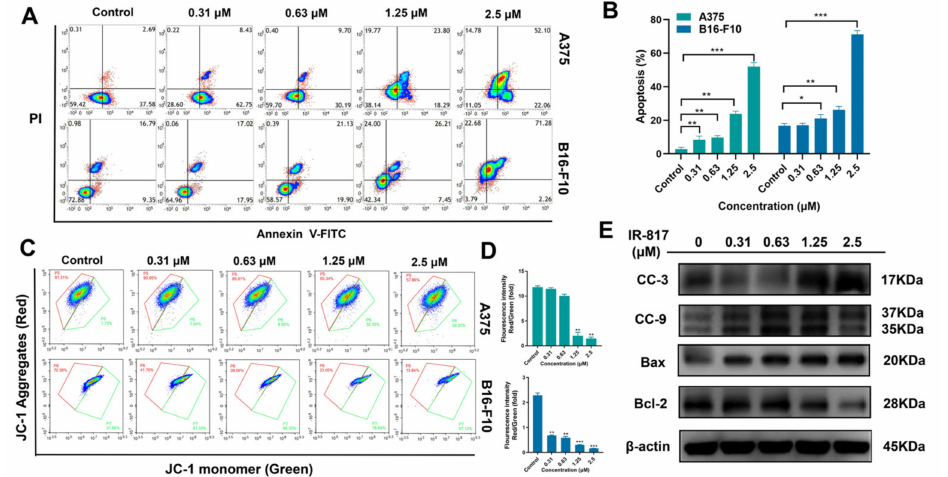
Figure 3. IR-817 induced apoptosis of melanoma cells A375 and B16-F10 through the mitochon- drial apoptotic pathway. ( A ) The apoptotic ratio of IR-817 treated with A375 and B16-F10 cells for 24 h were analyzed by Annexin V-FITC/PI staining. ( B ) The apoptotic effect was quantified and displayed as a histogram (mean ± SD, n = 3). ( C ) A375 and B16-F10 cells were treated with IR-817 at different concentrations (0–2.5 µ M) for 24 h, then stained with JC-1 and detected by flow cytometry. ( D ) Quantitative presentation of JC-1 positive monomer ratio (mean ± SD, n = 3). ( E ) Cleaved caspase-3 (CC-3), Cleaved caspase-9 (CC-9), Bax, and Bcl-2 protein levels. β -actin as internal reference. *** p < 0.001, ** p < 0.01, * p < 0.05, compared with